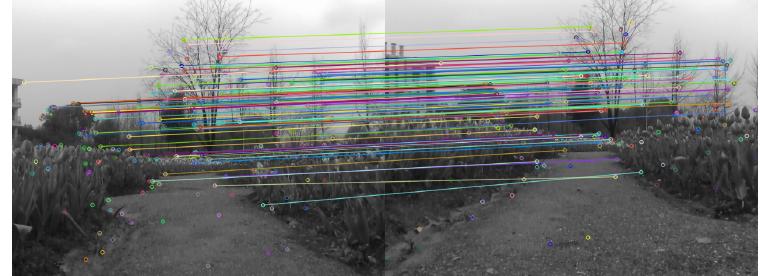
Figure 9. Results of feature precise matching.